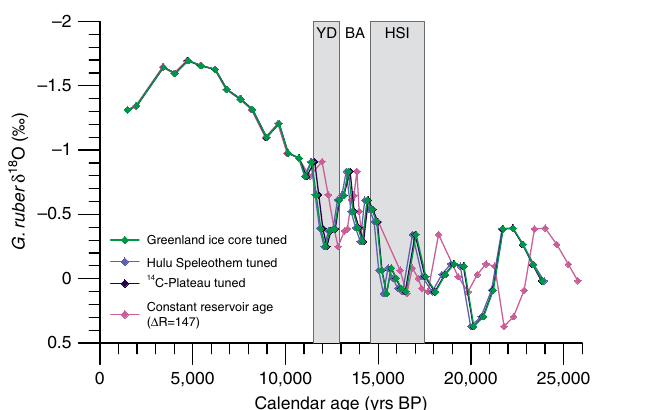
Figure 4 | Comparison of age model techniques. The three tuned age models yield results that are indistinguishable from one another within 1 s error windows. In contrast, the calibration of TR163–23 N. dutertrei 14 C- ages using a constant reservoir correction ( D R ¼ 147 ± 13) results in chronological offsets of up to B 2,000 years from the tuned age models.